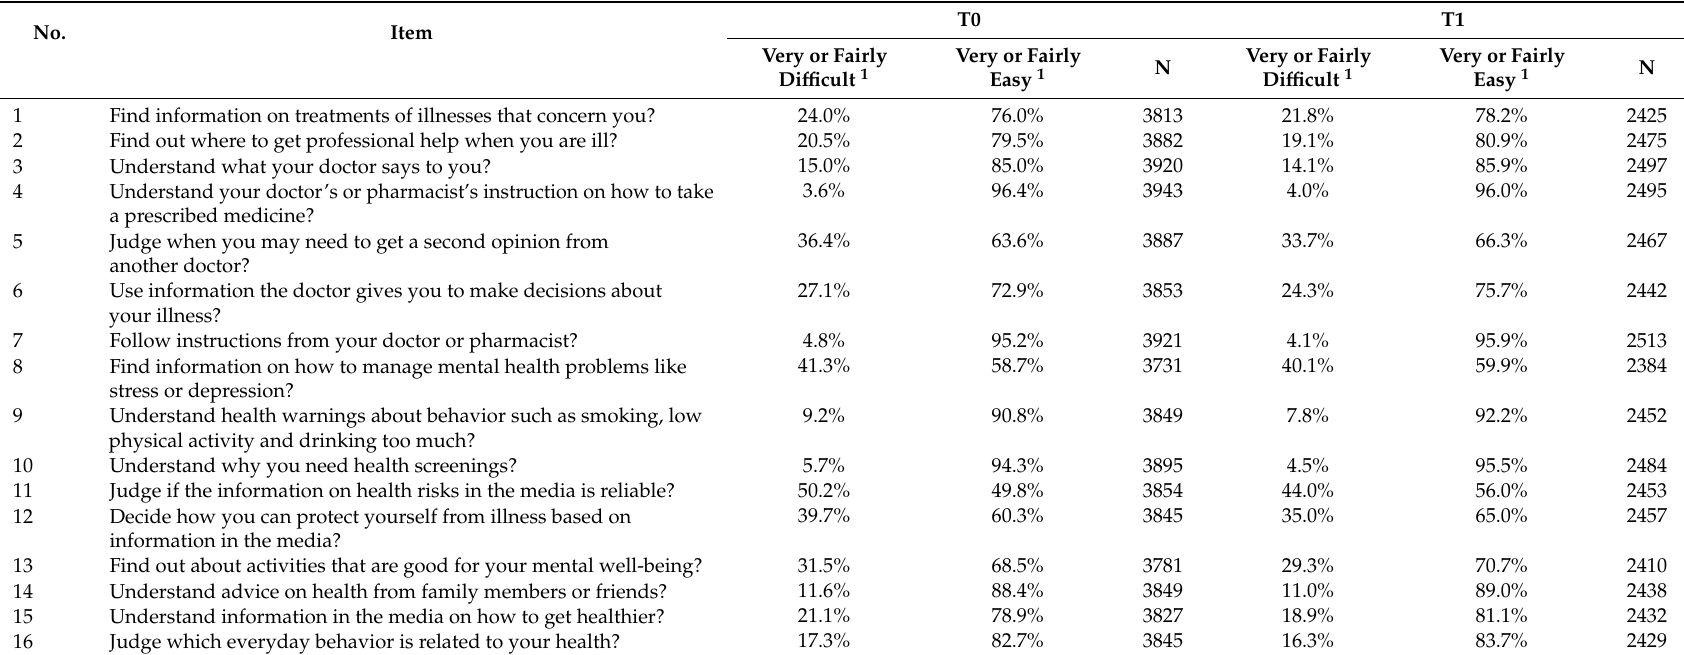
Table 5. European Health Literacy Short Scale (HLS-EU-Q16) Matrix Items (parents, T0 and